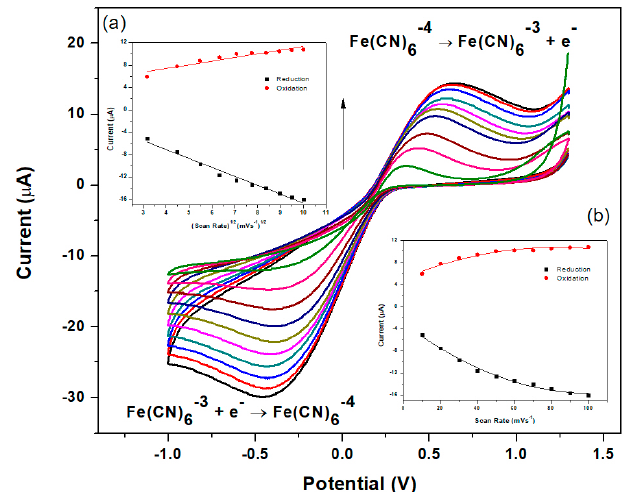
Figure 6. Electrochemical characterization of N-DMG-GCE in 5 mM Fe(CN) 63 − /4 − at scan rate of 10–100 mV s − 1 in supporting electrolyte (1 M KCl). Insets: plots of peak currents vs. ( a ) scan rate1/2 and ( b ) scan rate of the main oxidation and reduction